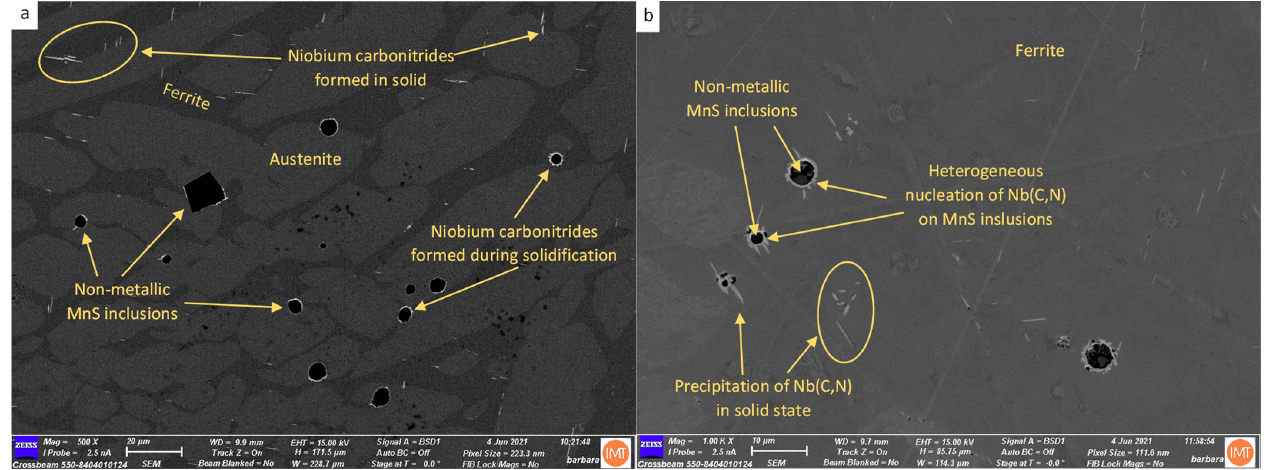
Figure 11. Backscattered electron image of ( a ) 5Ni-70 steel sample and ( b ) 0Ni-70.